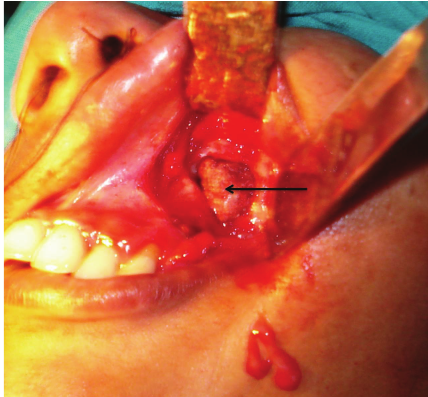
Figure 5: Caldwell-Luc operation revealing the antrolith.